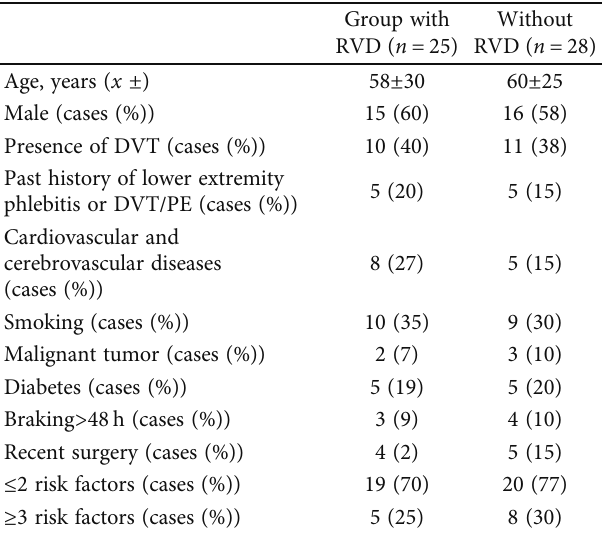
Table 1: Risk factors of 53 normotensive patients with acute pulmonary embolism.